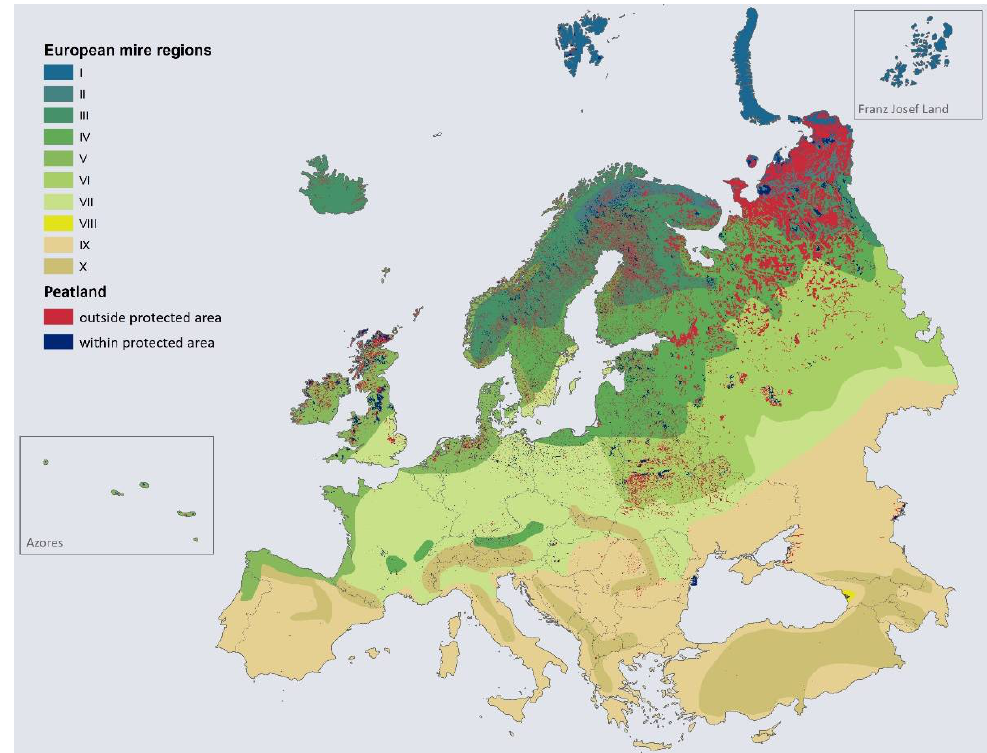
Figure 2. Peatland distribution (after [18]) and protection (after [34]; blue = within protected area, red = outside protected area) in the ten European mire regions (see Figure 1).